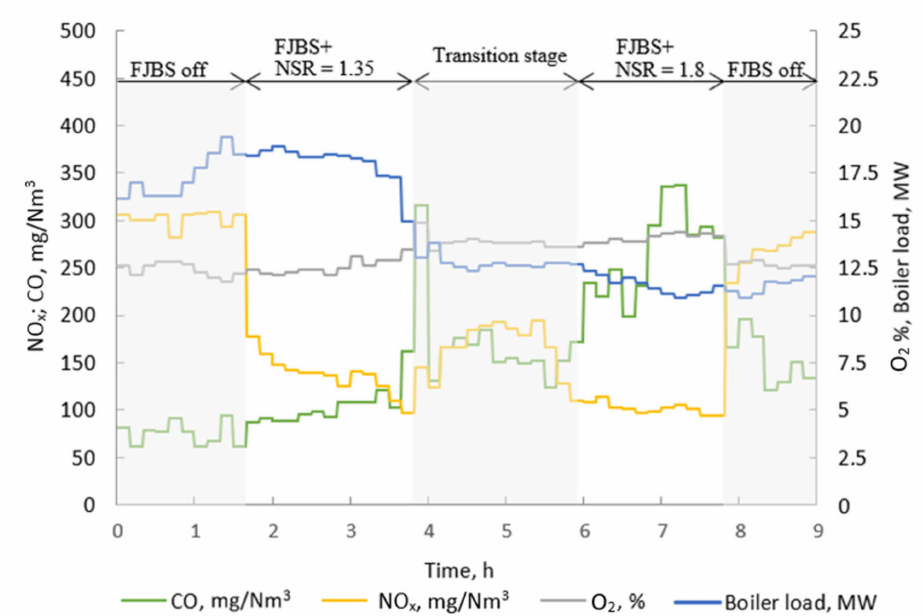
Figure 6. Stack emissions during the hybrid SNCR + SCR system operation at low/medium boiler load.